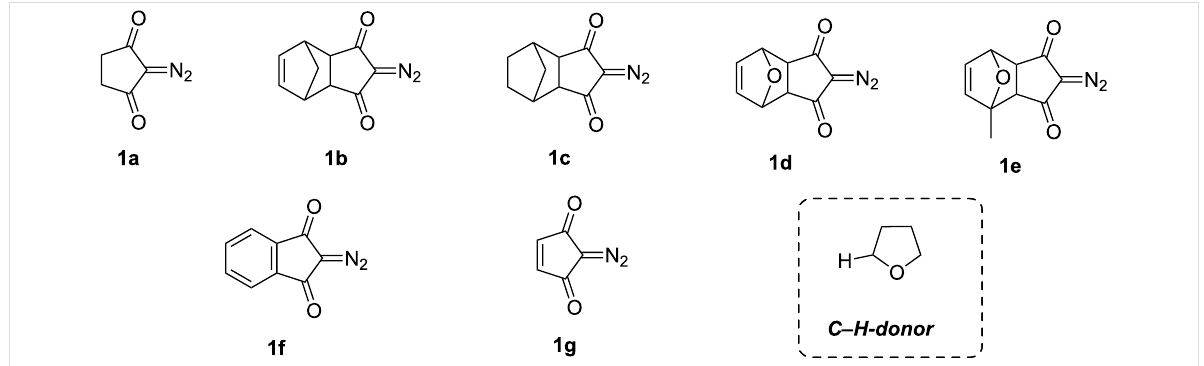
Figure 1: The structures of carbocyclic diazodiketones 1a–g and C–H-donating tetrahydrofuran used in the project.